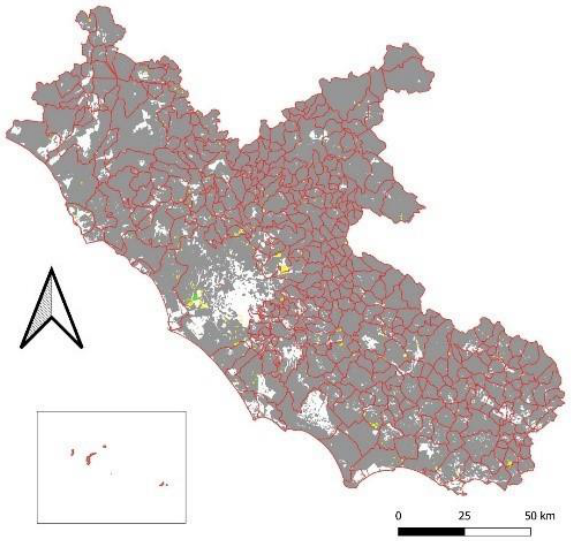
Figure 3 . Map with 'Landfills’ (green) and ‘Quarries' (yellow), in grey all unsuitable areas; red lines are municipalities